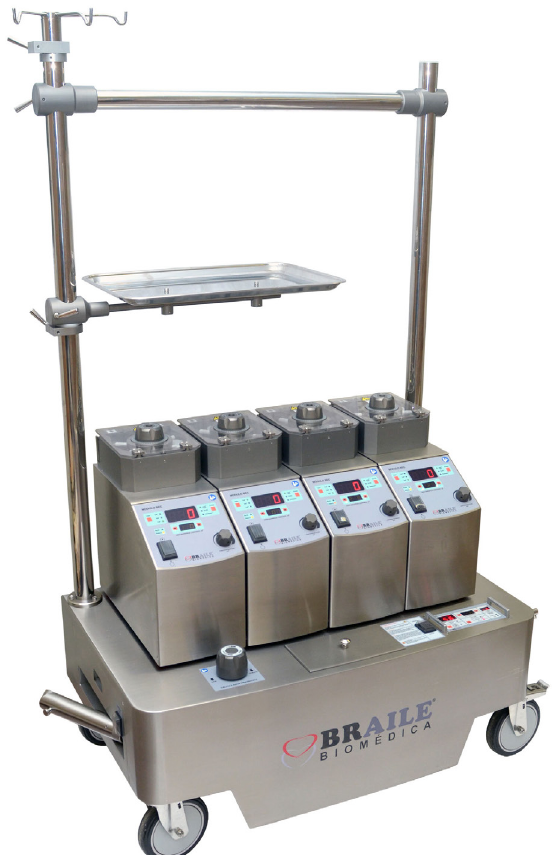
Fig. 5 - Modern roller pump. BEC Heart Lung Machine. Source: Braile Biomédica ®